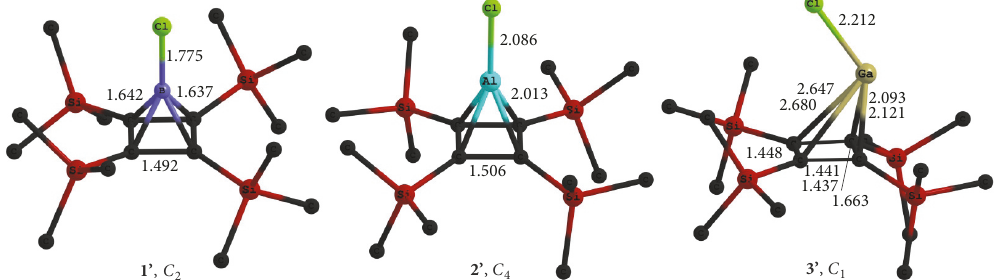
Figure 3: Optimized geometries (bond lengths are in ˚A) of minima structures 1 󸀠 –3 󸀠 . Hydrogen atoms are